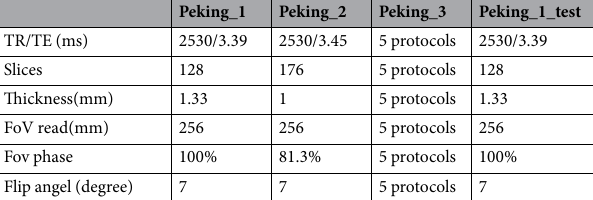
Table 6. Scan parameters for anatomical MRIs.